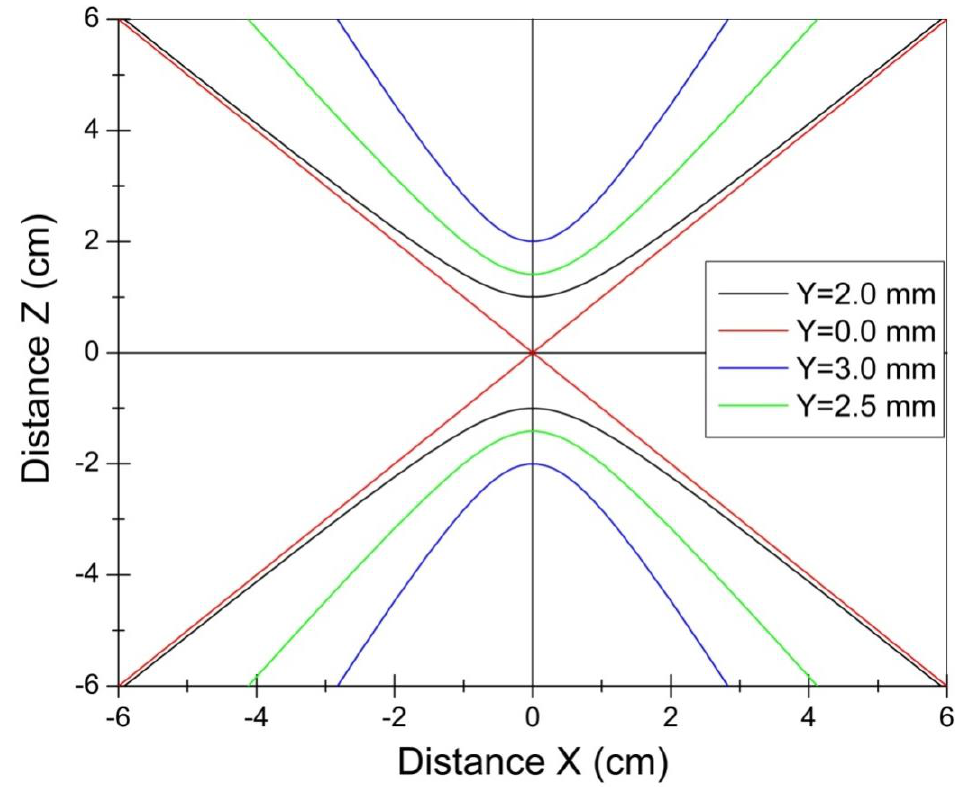
Figure 2. Hyperbolas representing the isogyres that are projected on the Ferrocell as a function of the distance of the center of the magnetic dipole in relation to the y-axis. The horizontal and vertical lines that pass through the origin are also isogyres. The two red lines that pass through the diagonals are the limit for the formation of two hyperbolas.